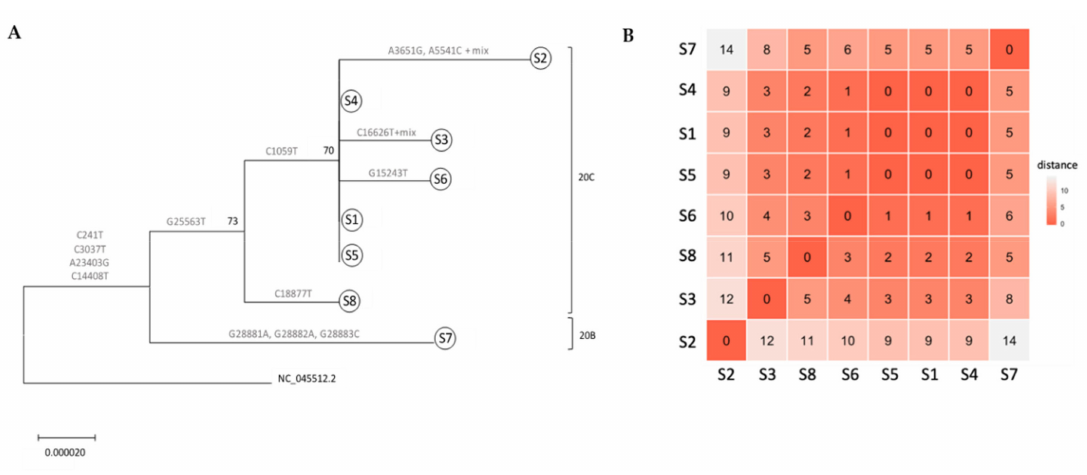
Figure 1. Whole genome-based phylogenetic tree of ICVL local outbreak. ( A ) Phylogenetic tree of six ICVL samples (S1–S6), two family-related samples (S7–S8) and SARS-CoV-2 reference sequence (NC 045512.2). Tree was inferred by maximum likelihood based on the GTR + I + G evolutionary model. The robustness of branching pattern was tested by 1000 bootstrap replications and the percentage of successful bootstrap replicates is indicated at the nodes, where only values of > 70% are shown. Mutational positions separating the samples are shown by each branch and corresponding 20B and 20C clades (according to Nextstrain nomenclature) are indicated. ( B ) Sample similarity clustering, calculated according to hamming distance (the number of di ff erent nucleotides across the whole genome sequences calculated for each pair of samples). Red represents the least di ff erence and white the most. The number of di ff erences is also